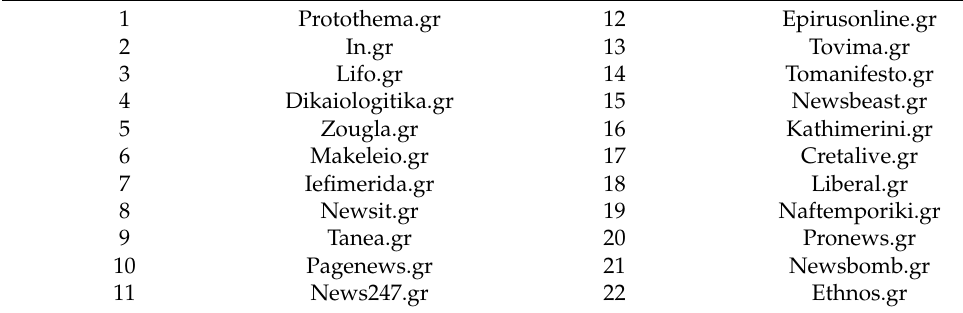
Table 1. Greek media websites (Alexa.com, accessed on 5 June